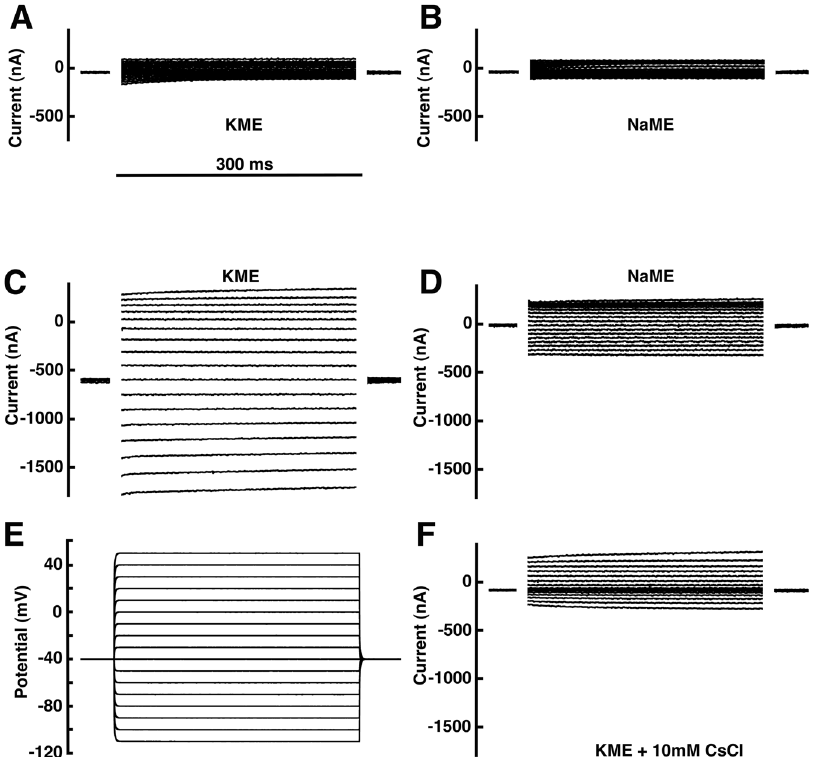
Figure 2. Electrophysiological characterization of TbIRK expressed in X . laevis oocytes. The 2-electrode voltage-clamp was used to study currents in oocytes injected with cRNA coding for TbIRK or with water. All recordings were done by applying the voltage-step protocol depicted in ( E ). The holding potential was − 40 mV. With a frequency of 1 Hz voltage-steps of 300 ms duration were applied from − 110 mV to 50 mV in 10 mV intervals. Currents recorded from a water-injected oocyte in potassium medium (KME) and sodium medium (NaME) are shown in ( A ) and ( B ). The corresponding representative current traces of a TbIRK-expressing oocyte in potassium medium and sodium medium (NaME) are shown in ( C ) and ( D ). ( F ) Recording of the same oocyte in potassium medium in presence of 10 mM